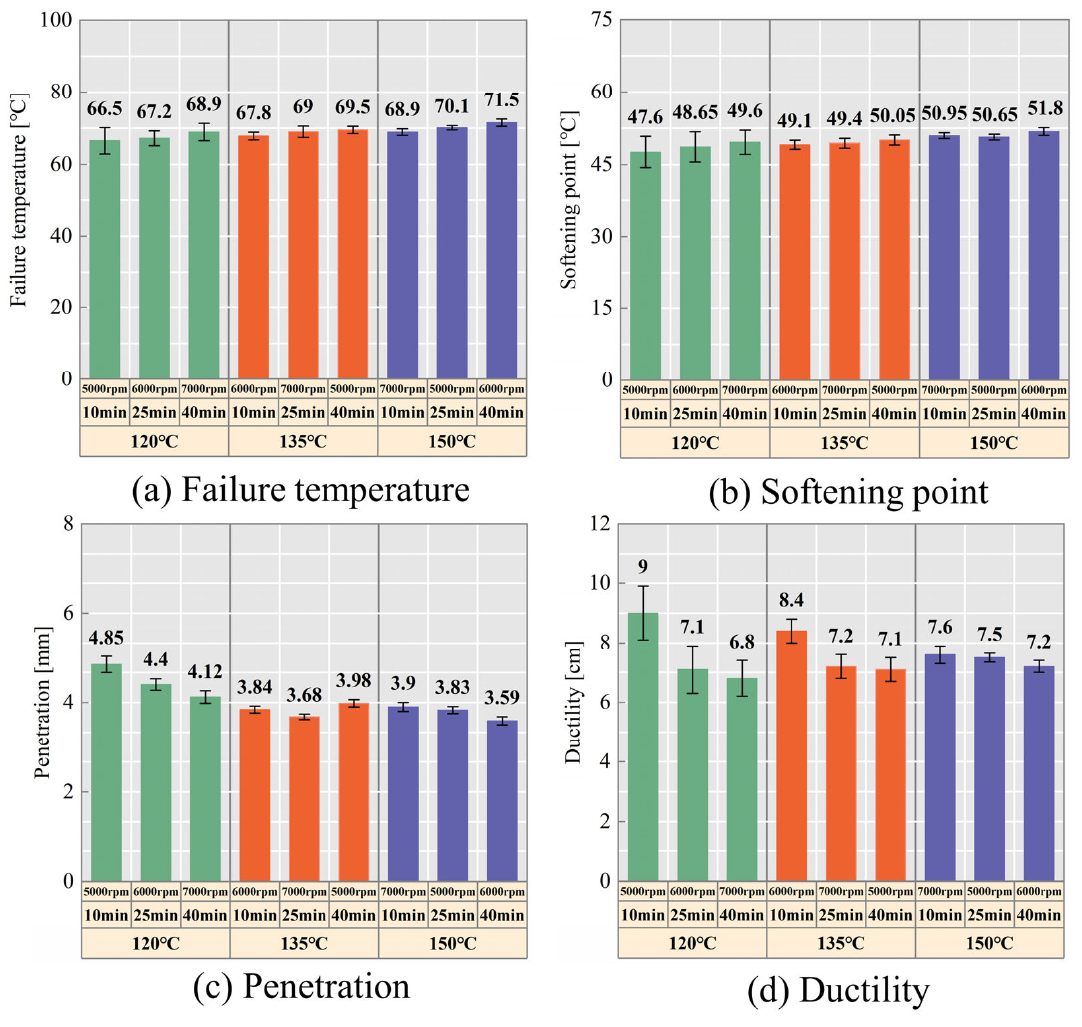
Figure 5. Orthogonal experimental results. Table 5. Failure temperature range analysis